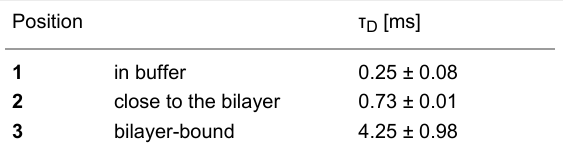
Table 1: Diffusion times, τ D (ms), of LON 10 in the presence of a lipid bilayer. Position: 1 - buffer; 2 - solution in close proximity to the bilayer; 3 - bilayer-bound.